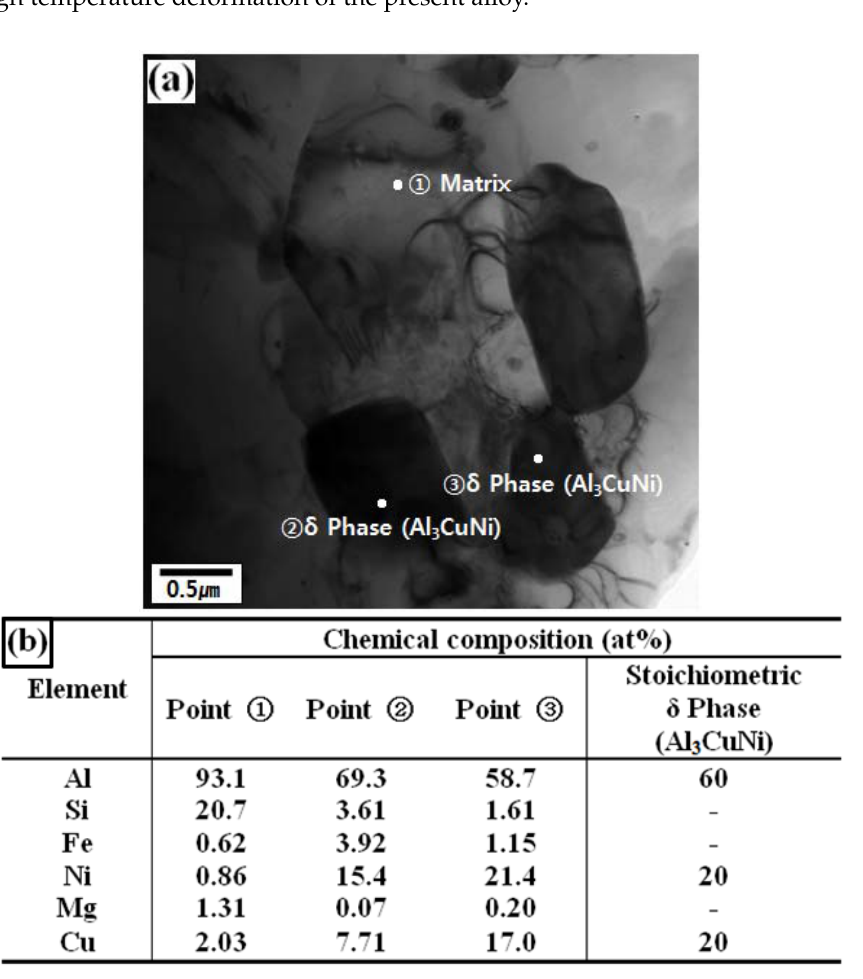
Figure 11. ( a ) TEM image and ( b ) EDS data of the specimen deformed to 20% of true-strain at a strain rate of 1/s at 470 °C.